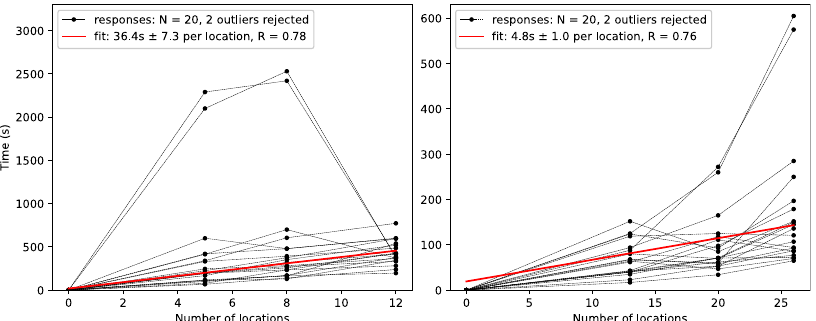
Fig. 6 Regressions on survey responses for look up time (left) and route generation time (right). In both cases, two survey responses were deemed outliers and excluded from the regression. The two extremely high response times came from respondents who used a physical map to complete the task (as opposed to a digital service such as Google